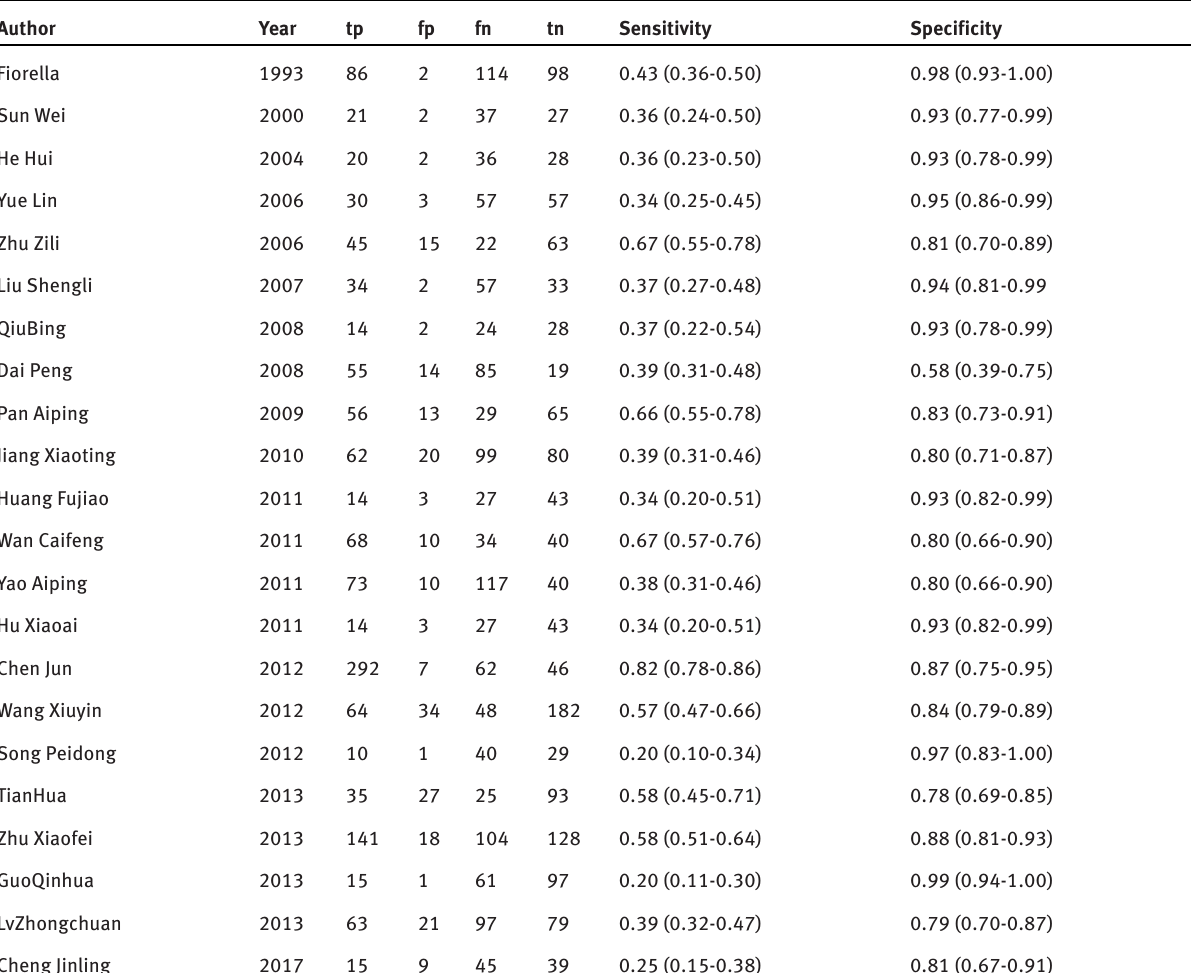
Table 1: The main character of the included 22